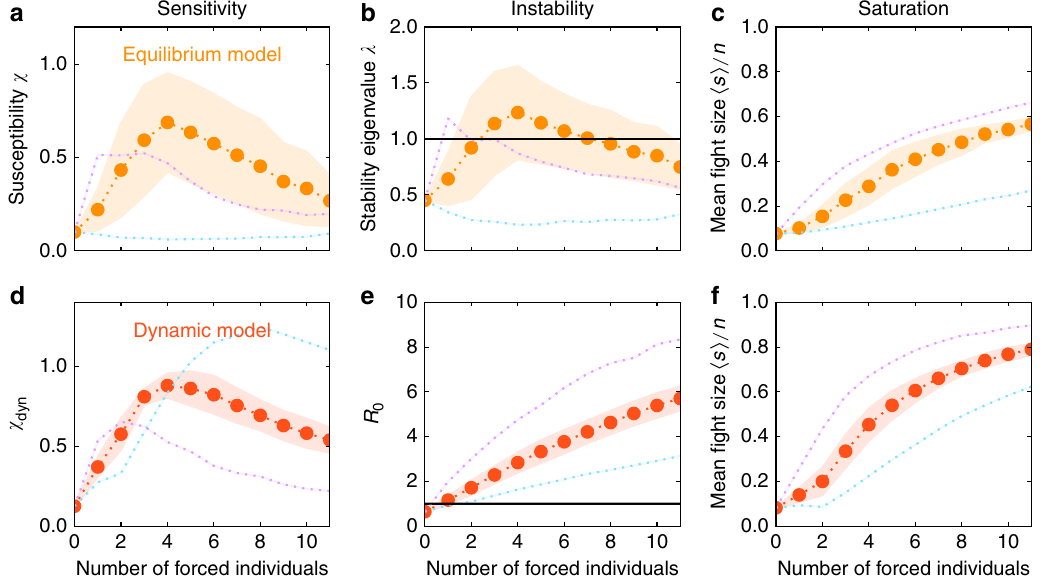
Figure 3 | Simulation of forced individuals provides a biologically meaningful measure of distance from criticality. In equilibrium ( a – c ) and dynamic ( d – f ) models, forcing a few individuals to become simultaneously aggressive leads to a more sensitive system. ( a , d ) In each model, peak sensitivity is reached when on average 3–5 individuals are forced. Shaded regions indicate the standard deviation around the mean over different realizations of the chosen individuals. Purple and blue dotted lines indicate choices of forced individuals that maximize and minimize the resulting mean fight size. ( b , e ) The lowest-order stability measured in each model, corresponding to the eigenvalue l 0 in the equilibrium model and R 0 in the dynamical model (Supplementary Note 3). A value above 1 in each case indicates instability to linear order. ( c , f ) The mean fight size. See Supplementary Note 4 for details about the ordering of forced